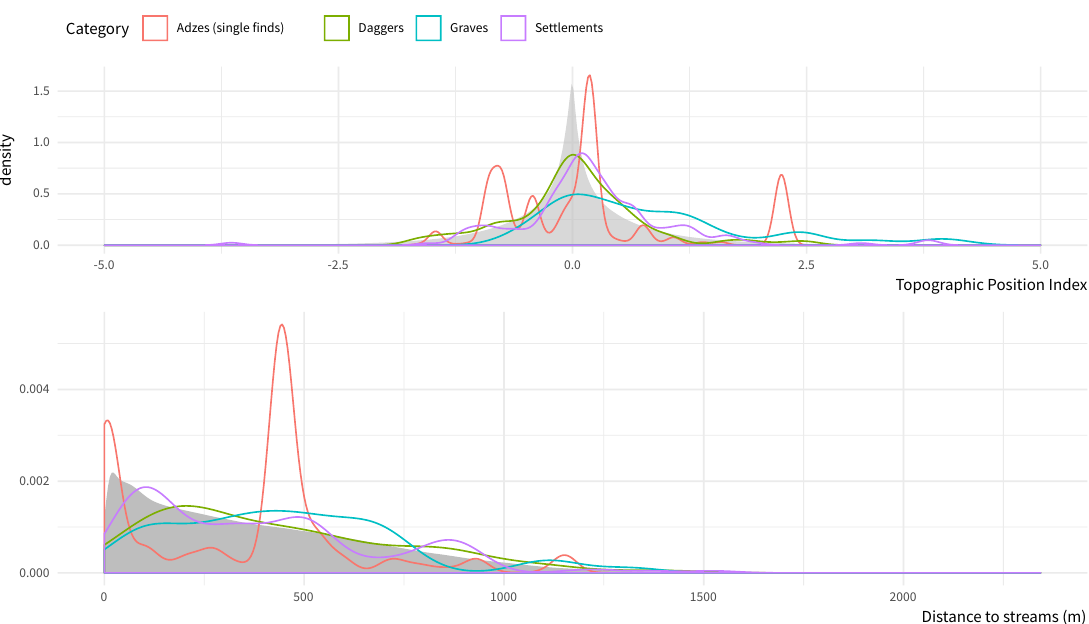
Figure 8. The occurrence of archaeological sites in relation to their distance to streams during Neolithic phases. Graves and stone adzes changed in their location preferences, while settlements generally tended toward localizing at short distances from streams. Characteristics of study area (gray shaded area) and archaeological findings